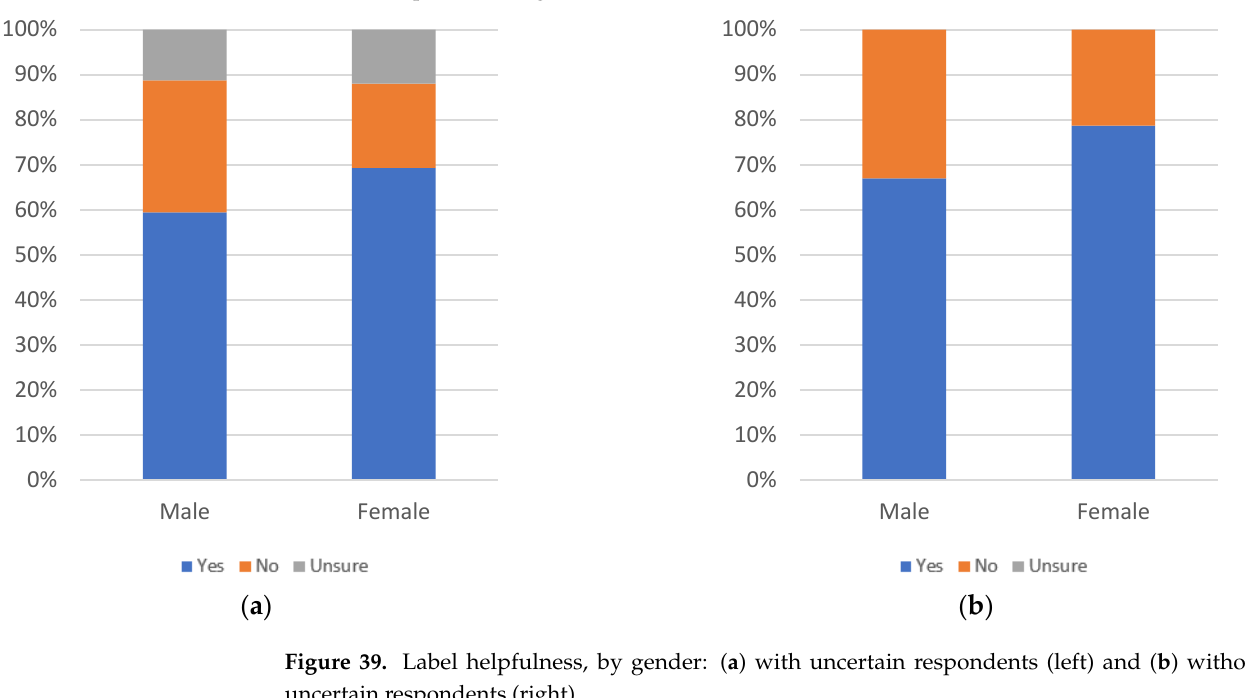
Figure 38. Label helpfulness, by education level: ( a ) with uncertain respondents (left) and ( b ) without uncertain respondents (right).